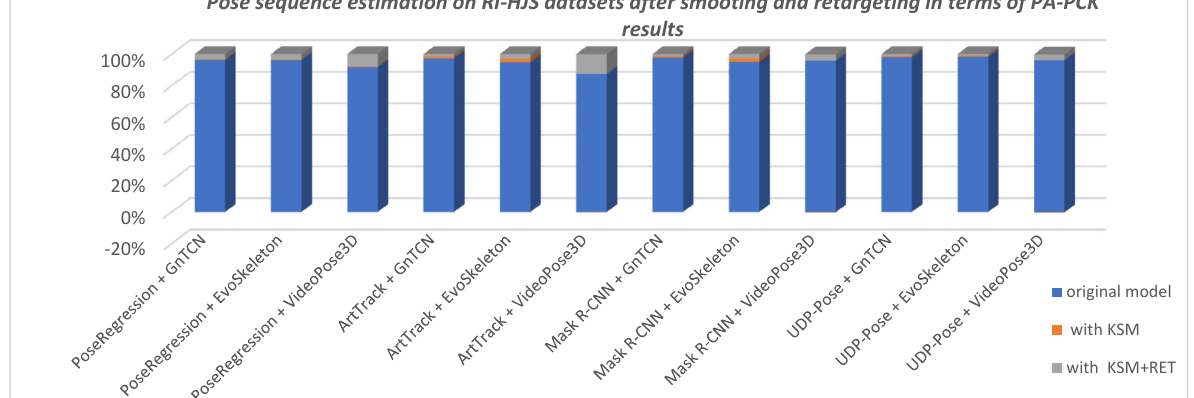
Figure 17. Comparison of pose sequence estimation in terms of PA ‐ MPJPE measure on Human3.6M datasets (lower is better). All models show a slight improvement when using smoothing on the sequence of poses, showing the lack of consistency in the detection location of keypoints and “lift ‐ ing” 2D keypoints to the 3D space. An exception to this conclusion is the VideoPose3D model, which constructed a smooth sequence of poses by utilizing temporal information. When using retargeting on the ground truth and smoothed predicted sequence, results are significantly improved, which indicates that all models lack an understanding of the human skeleton structure. The average improvement using 3D predicted sequence smoothing (KSM) is 0.7% for the PCK metric (i.e., 0.57% on Human3.6M and 0.84% on RI ‐ HJS) and 1.4% for the MPJPE metric (i.e., 1.26% on Human3.6M and 1.52% on RI ‐ HJS). Retargeting to standardize both predicted sequence bone lengths and ground truth improved the overall result in all cases. The average improvement using retargeting and smoothing (KSM+RET) is 3.87% for the